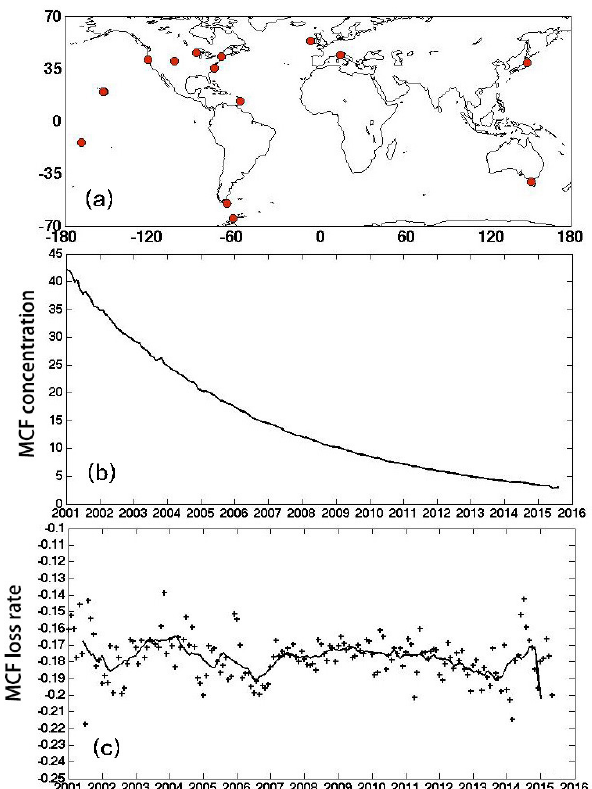
Figure 4. (a) Locations of WDCGG sites with MCF measurements. (b) Global mean MCF concentration. (c) Exponential loss rate of MCF, derived from the 12-month difference of monthly means (e.g., ln(MCF Jan2007 /MCF Jan2006 ) ). The black solid line shows the 12- month mean value.